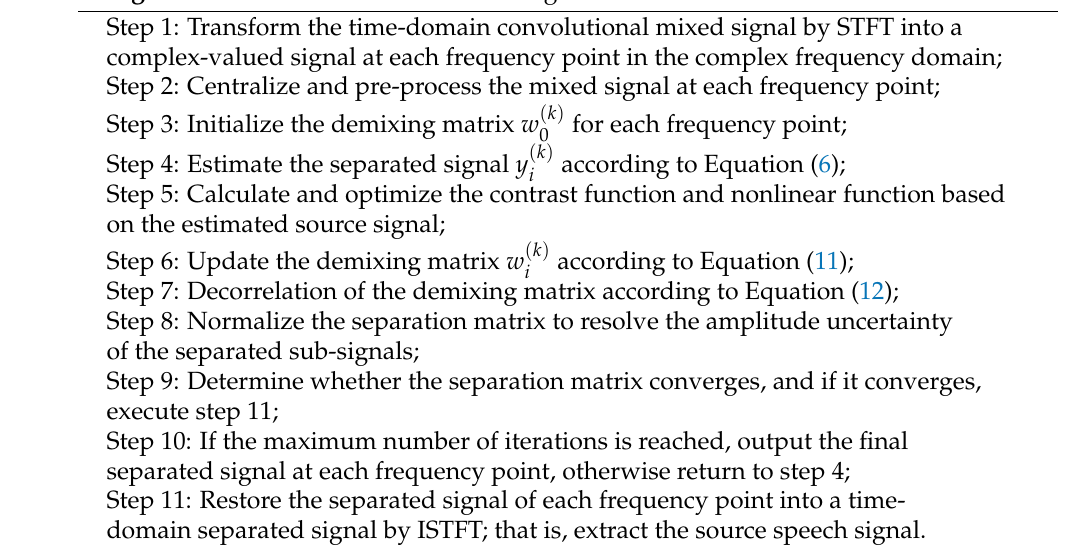
Algorithm 1: CBSS based on Fast IVA